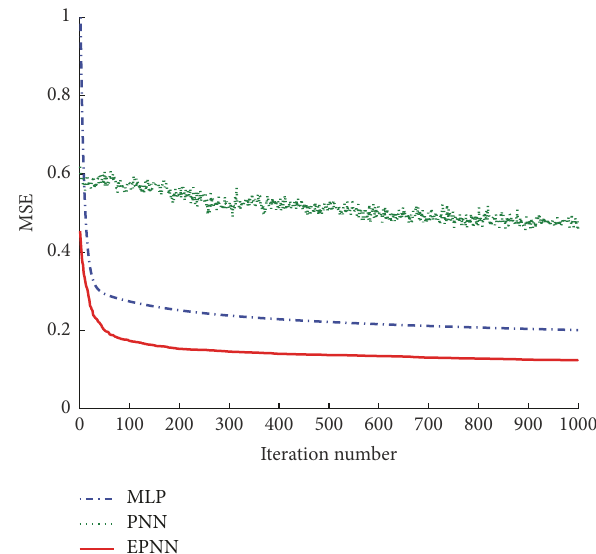
Figure 6: The convergency curve of the Distress data set.